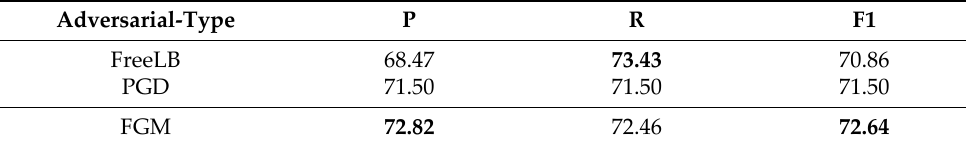
Table 7. Performances of various Adversarial Training on Weibo NER dataset.